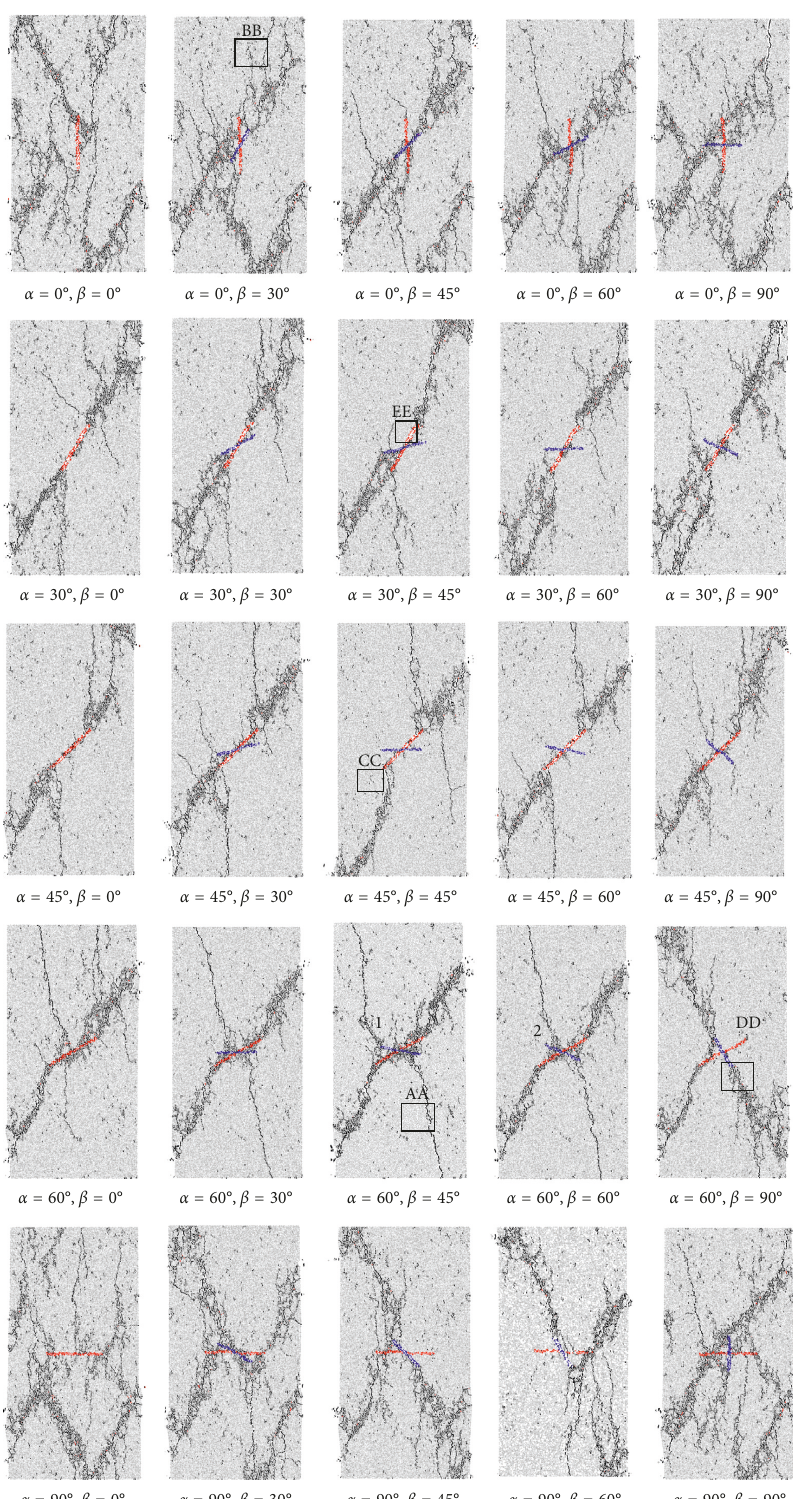
Figure 6: Failure patterns of granites containing a set of cross-joints with different